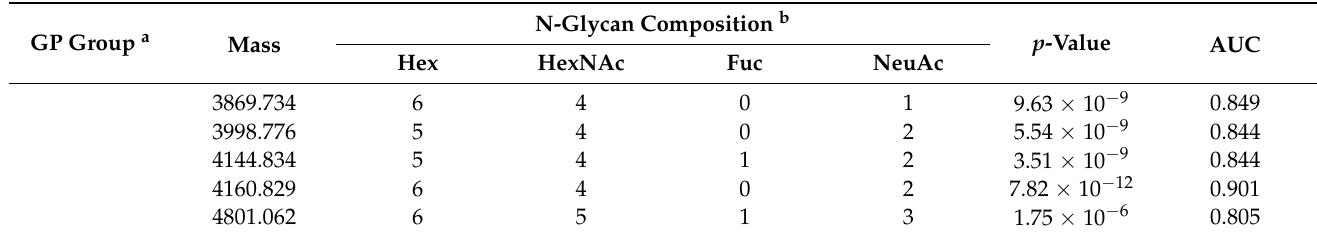
Figure 3. Site-specific glycosylation mapping of the haptoglobin standard purified from commercial human sera. For GP1 and GP3, the top 10 representative major glycoforms for each glycosylation site were indicated. Bi-antennary di-sialylated N-glycan occupies more than 50% of the total for each site. The sizes of N-glycan cartoon on GP1 and GP3 represent their relative abundance in each glycopeptide group. The biggest is more than 10%; medium is more than 1%; the smallest is less than 1%. In GP2 with two glycosylation sites, the denoted N-glycan cartoon is the composition most probable to constitute the top 10 glycopeptides of GP2 based on the abundance of haptoglobin glycan profiling.